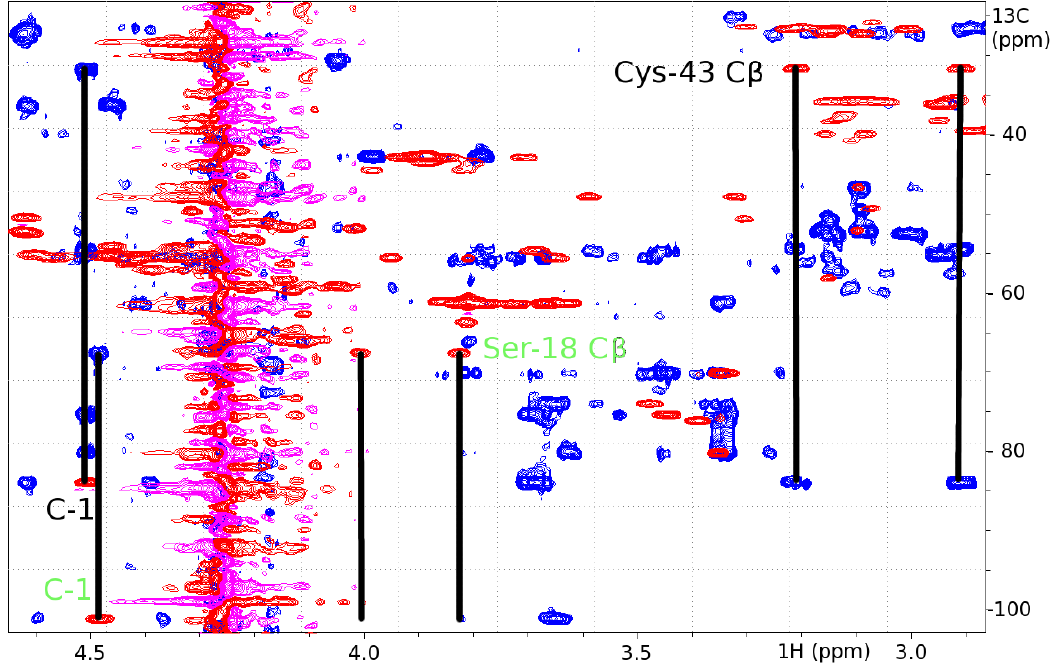
Figure 3. Overlay of 1 H- 13 C HSQC (red) and 1 H- 13 C HMBC (blue). Connectivities between the C-1 atom of a GlcNAc (83.723 ppm, 4.508 ppm) to the β -carbon of Cys-43 (31.471 ppm, 3.214 and 2.906 ppm) and of the C-1 atom of a second GlcNAc residue (100.952 ppm, 4.479 ppm) to the β -carbon of Ser-18 (67.330 ppm, 4.006 and 3.819 ppm) are indicated by solid